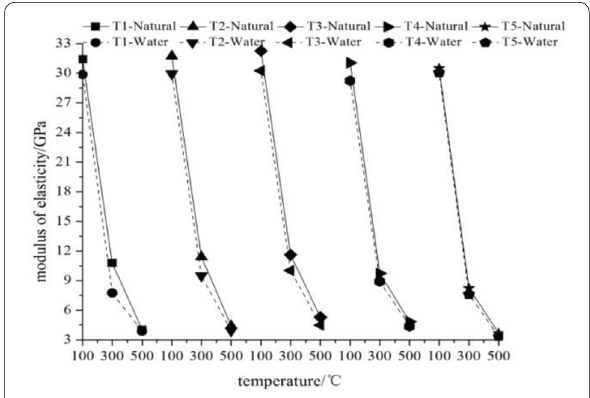
Fig. 17 Relation between the elasticity modulus of concrete produced with desert sand and temperature under different regimes.